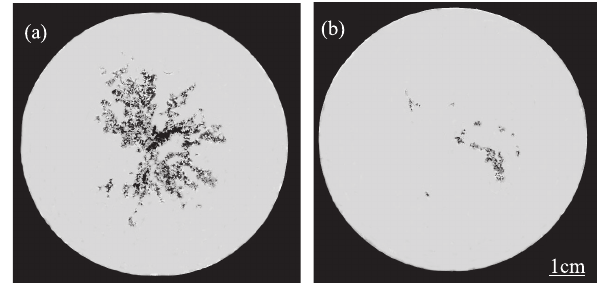
Fig. 4: Shrinkage porosity of IN100 superalloy castings in